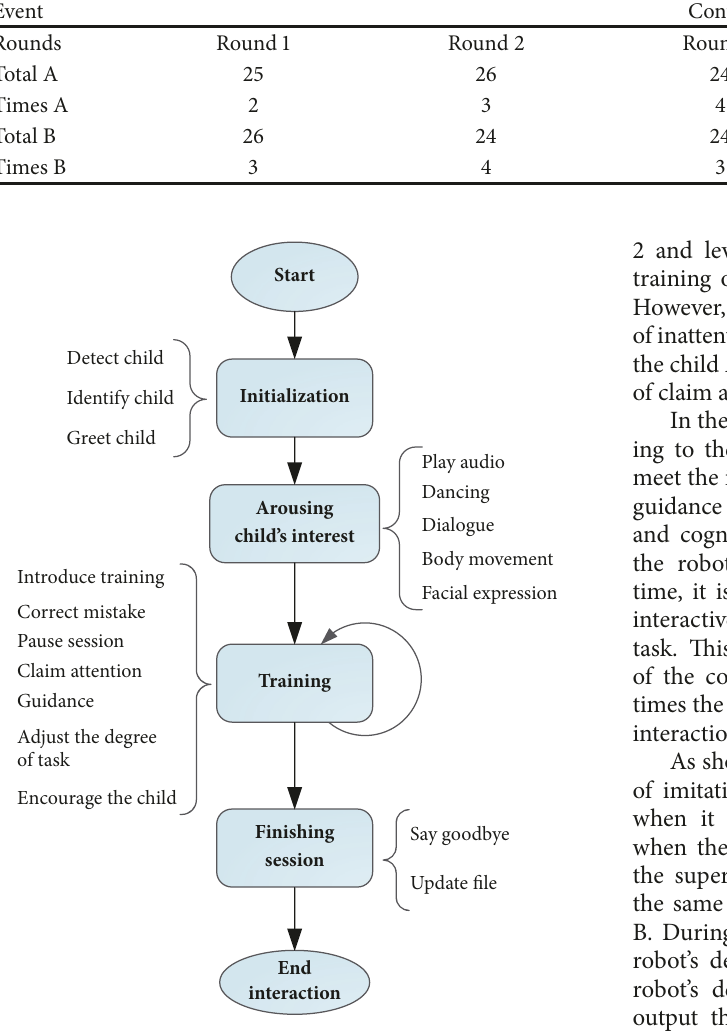
Figure 9: Phases of the interaction